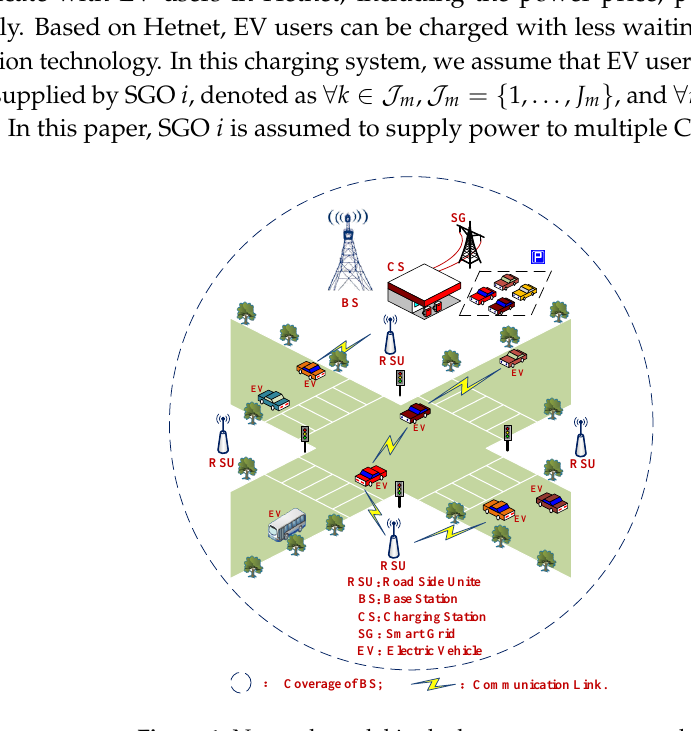
Figure 1. Network model in the heterogeneous